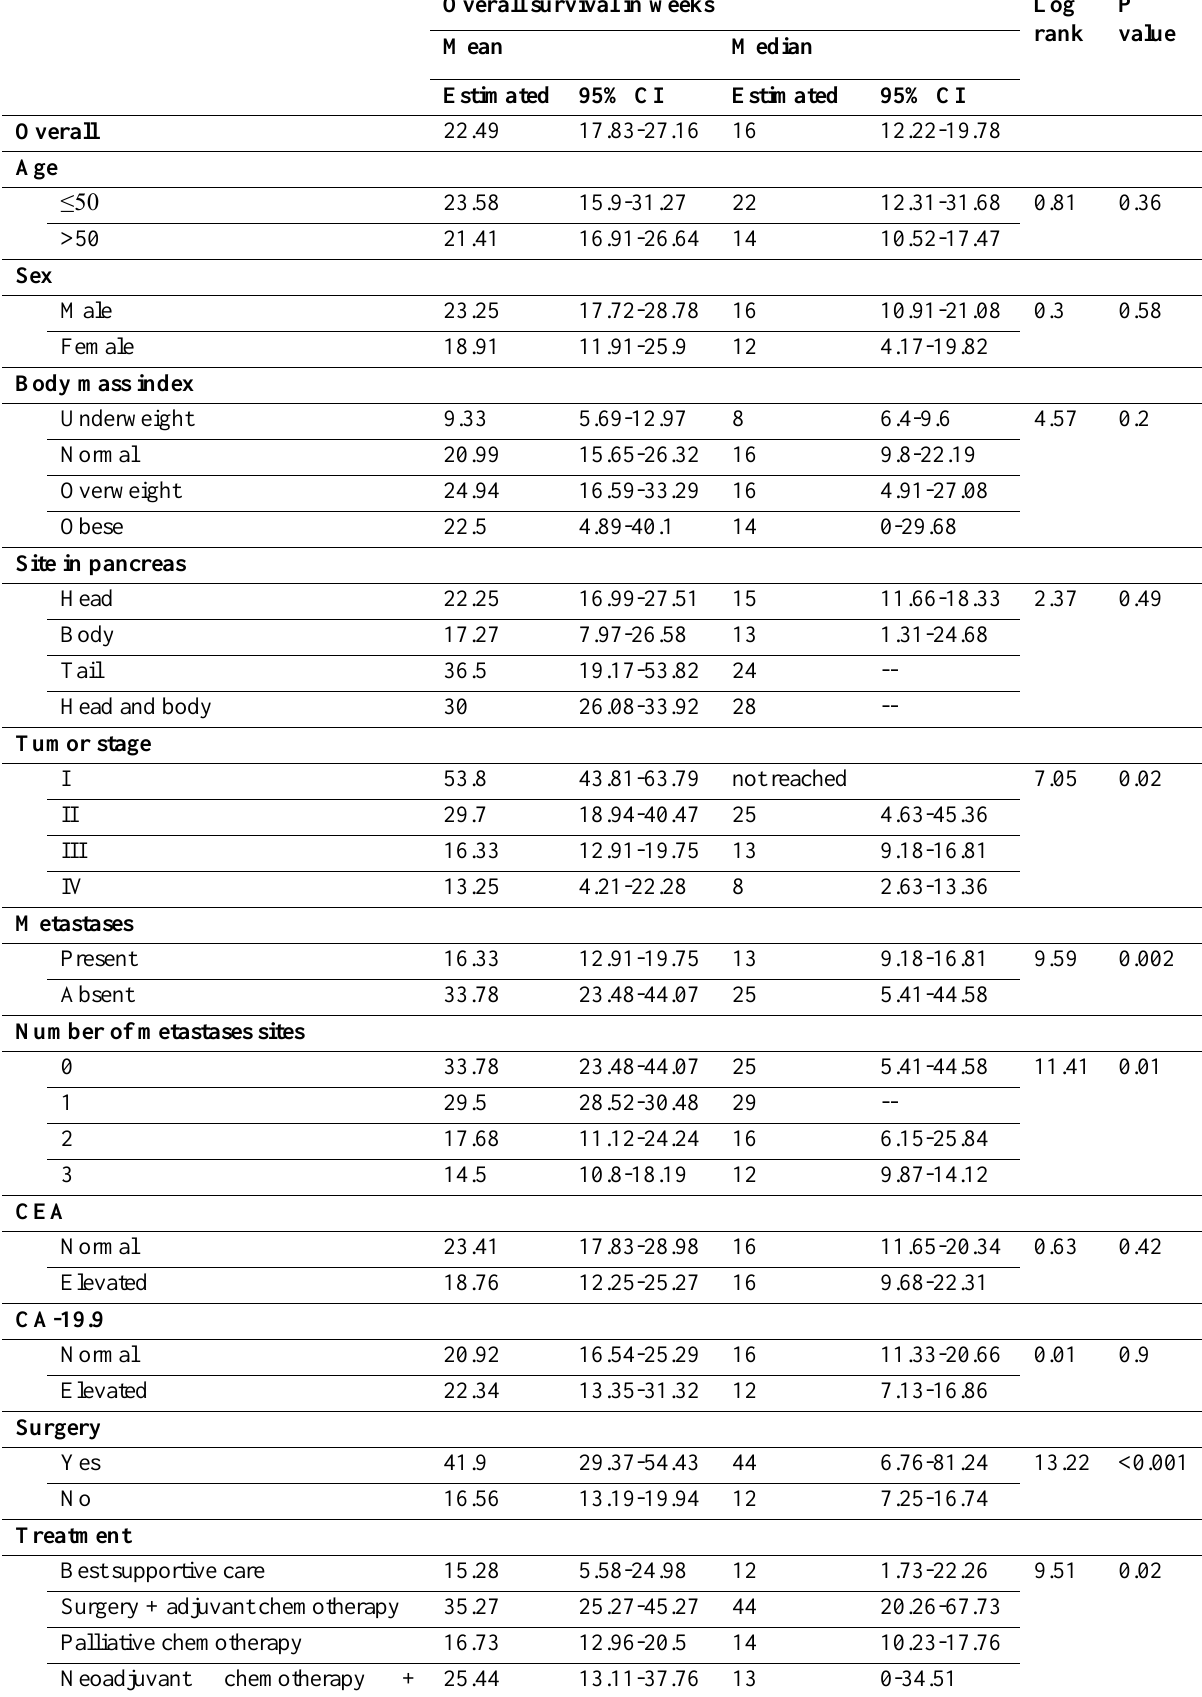
Overall survival in weeks Log